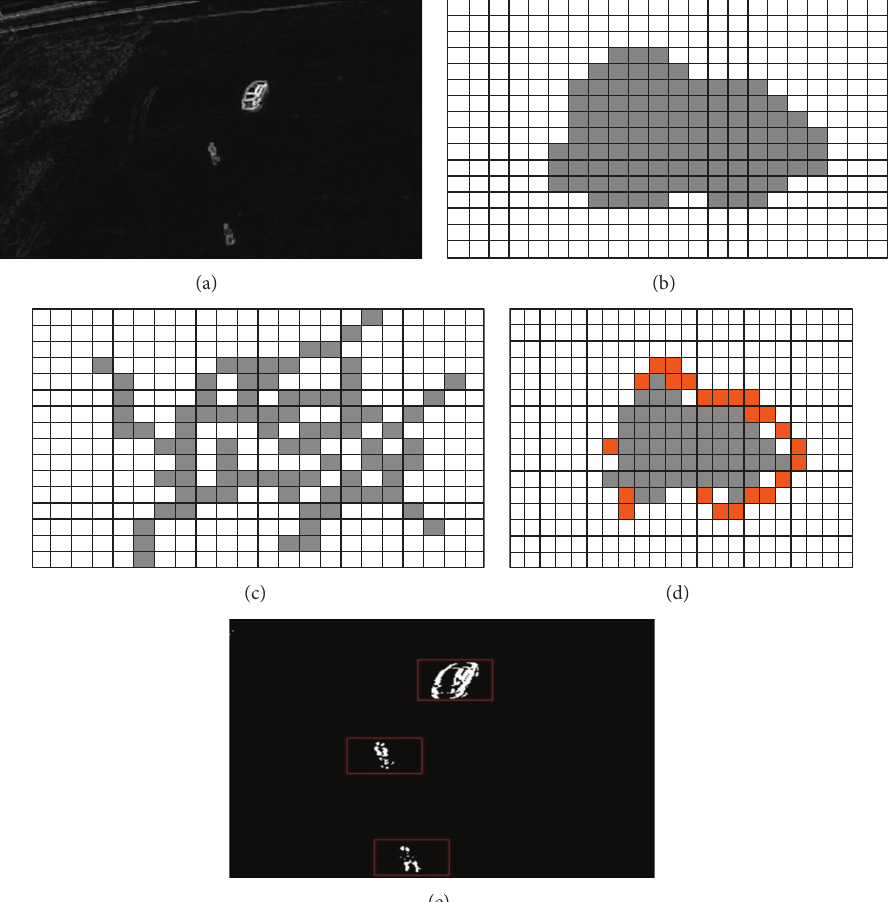
Figure 8: (a) 𝐹𝐷 𝑏 (𝑚,𝑛, 𝑡) . (b) Conventional dilation: 𝐹𝐷 𝑏 (𝑚,𝑛, 𝑡) ⊕ 𝐿 = {𝑥 | 𝑥 = 𝑖 + 𝑗; 𝑖 ∈ 𝐹𝐷 𝑒 (𝑚,𝑛, 𝑡);𝑗 ∈ 𝐿} . (c) Analysis of edge based dilation from 𝐹𝐷 𝑒 (𝑚,𝑛,𝑡) . (d) Edge based dilation: 𝐹𝐷 𝑑 (𝑚,𝑛, 𝑡) = 𝐹𝐷 𝑒 (𝑚,𝑛, 𝑡) ∪ {𝑥 | 𝑥 = 𝑖 + 𝑗; 𝑖 ∈ 𝐹𝐷 𝑒 (𝑚, 𝑛,𝑡)} ; 𝑗 ∈ 𝐿; Edge (𝑥) ̸=0 . (e) Output after SUED: 𝐹𝐷 𝑒 (𝑚, 𝑛,𝑡)